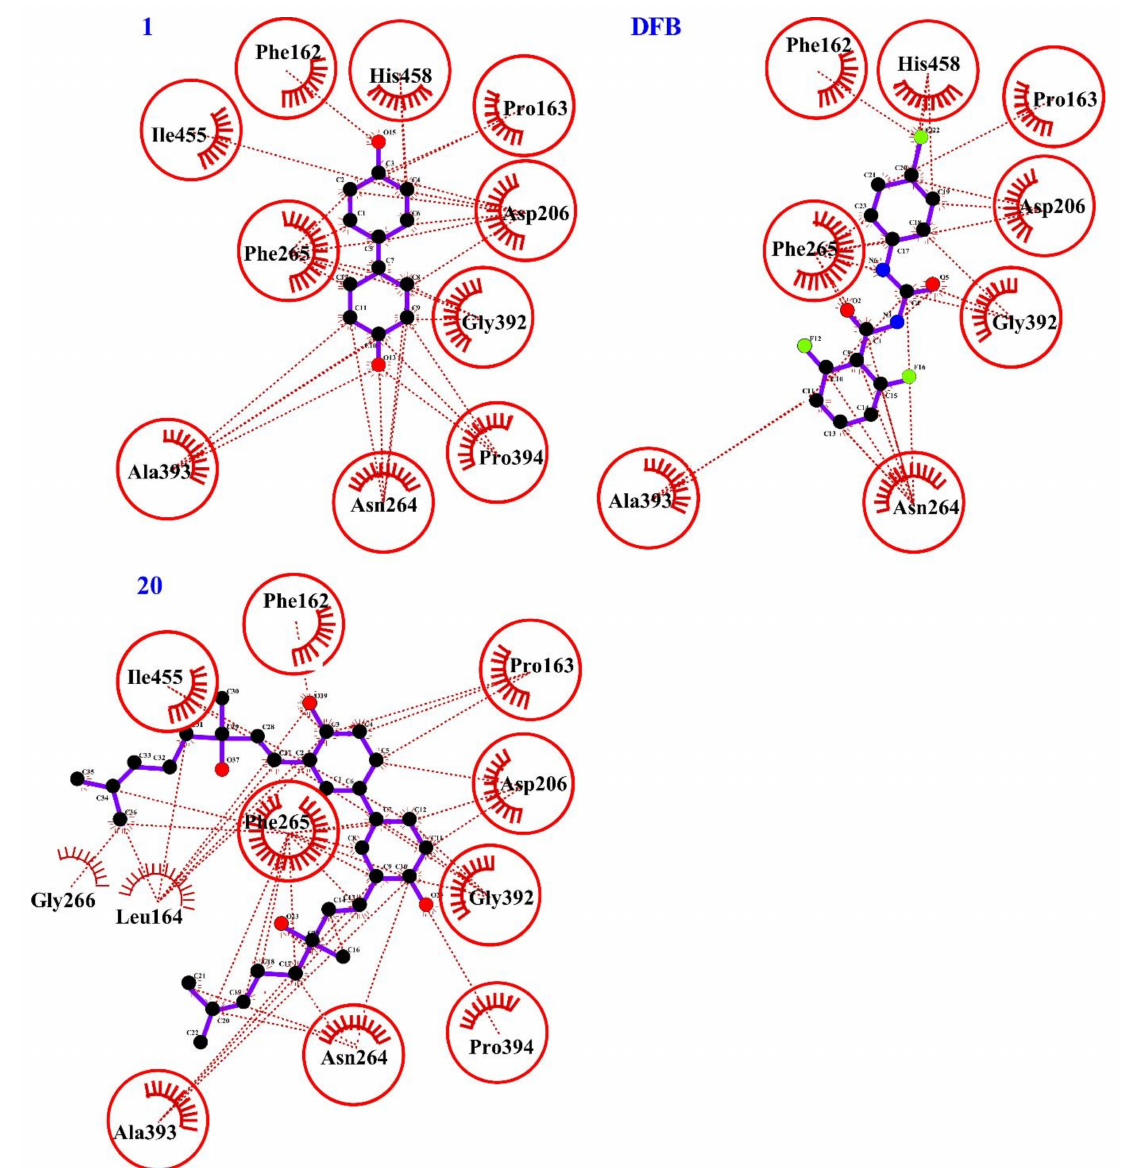
Figure 5. Hydrophobic interactions of DFB , compounds 1 and 20 with the catalytic T1 site of laccase, respectively and performed with LigPlot +